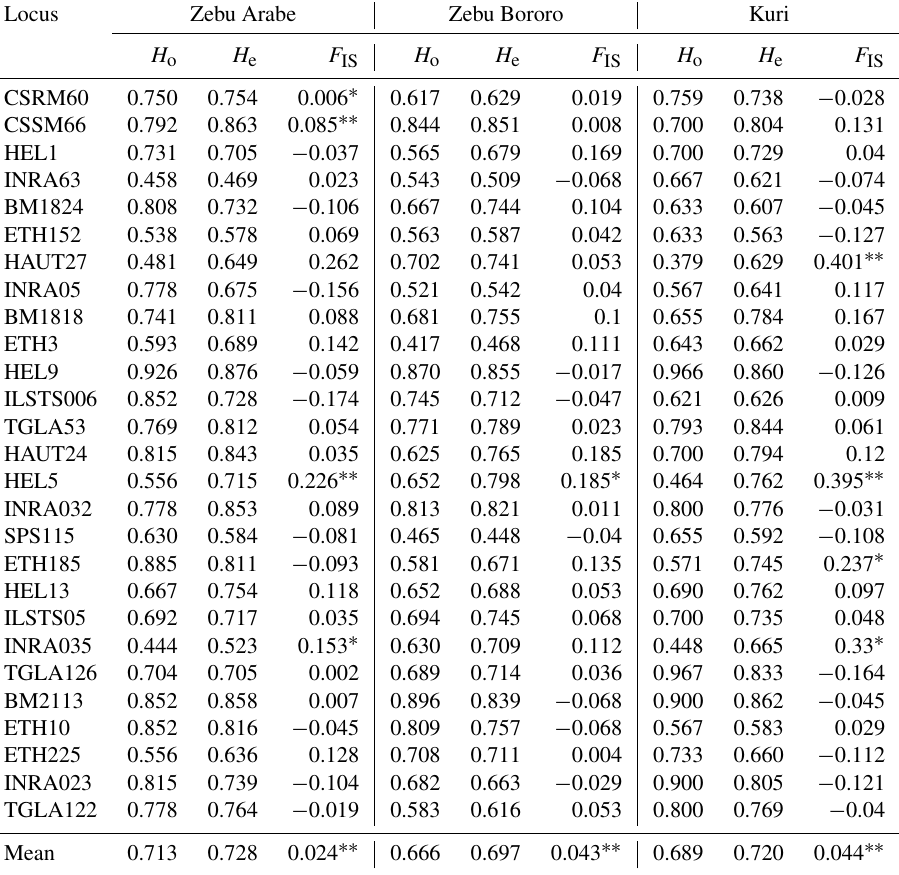
Table 2. Observed heterozygosity ( H o ), expected heterozygosity ( H e ) and estimated heterozygosity deficit ( F IS ) at different loci in Zebu Arabe, Zebu Bororo and Kuri breeds of Niger